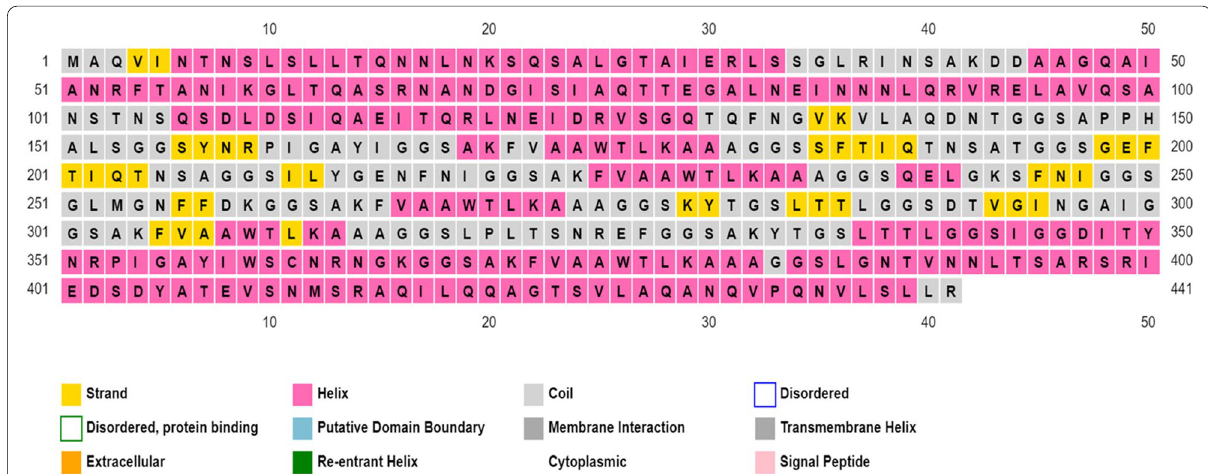
Fig. 2 Secondary structure prediction of the vaccine constructs: The strands are represented in yellow, the helix sections are shown in pink, and membrane contact and transmembrane helix regions are shown in gray color